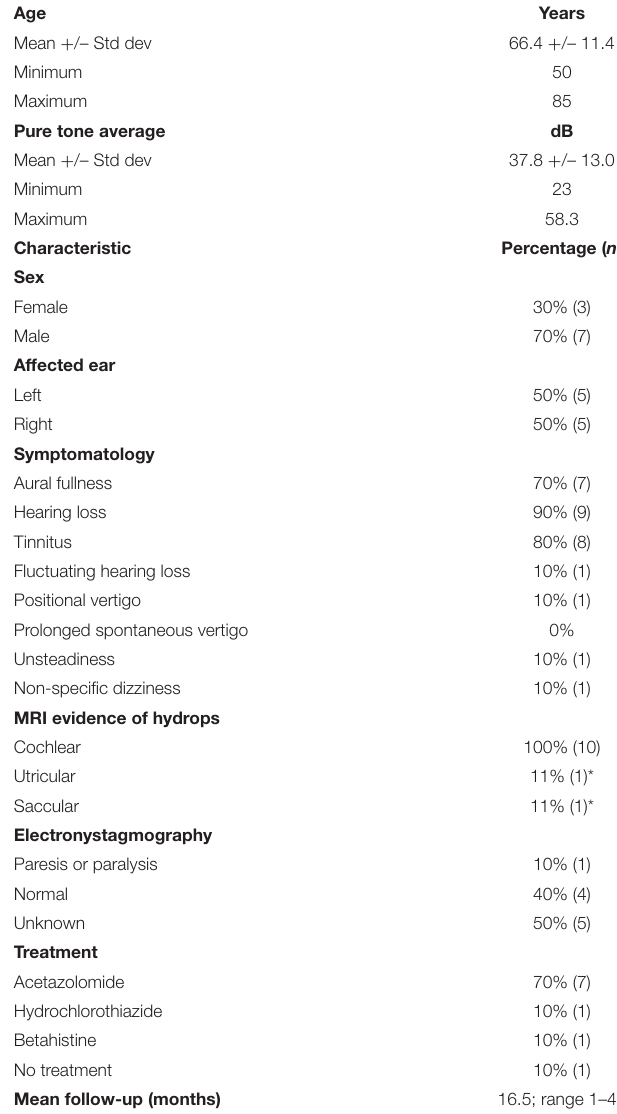
TABLE 1 | Pure tone average (PTA) of the affected ear and follow-up for each patient. Case